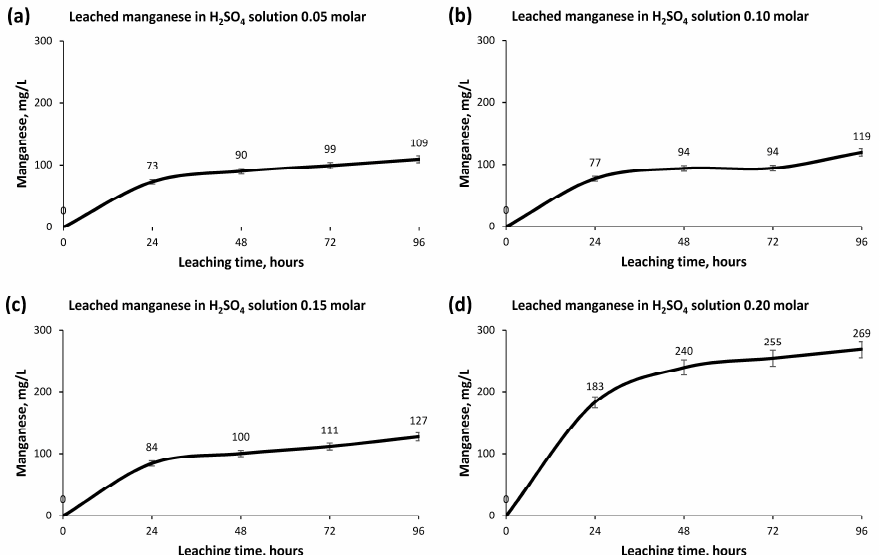
Figure 8. Analysis of the concentration of Manganese in the leaching process at atmospheric pressure, ambient temperature and in different solutions of Sulphuric Acid: ( a ) 0.05 molar H 2 SO 4 solution, ( b ) 0.10 molar H 2 SO 4 solution, ( c ) 0.15 molar H 2 SO 4 solution and ( d ) 0.20 molar H 2 SO 4 solution.